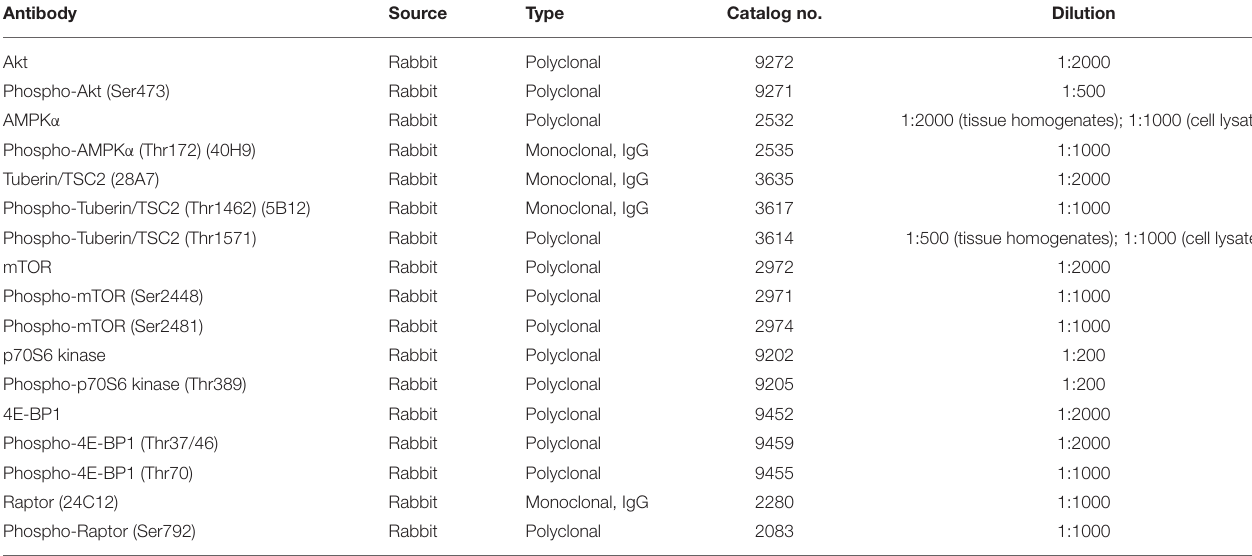
male fetuses, and one-min and five-min Apgar scores were also similar. Nevertheless, women with GDM and LGA infants had higher mean 1 h and 2 h plasma glucose concentrations at 75 g oral glucose tolerance tests than women with normal or FGR pregnancies. Women with GDM and LGA infants also had higher mean birth weights and placental weights than the other two groups. In contrast, women with pregnancies complicated by FGR had lower mean birth weights and placental weights than women with normal pregnancies or women with GDM and LGA infants. Two women with pregnancies complicated by FGR were associated with abnormal Doppler velocimetry of the umbilical artery blood flow (absence of end-diastolic flow velocity). Four women with GDM received insulin treatment in addition to nutritional